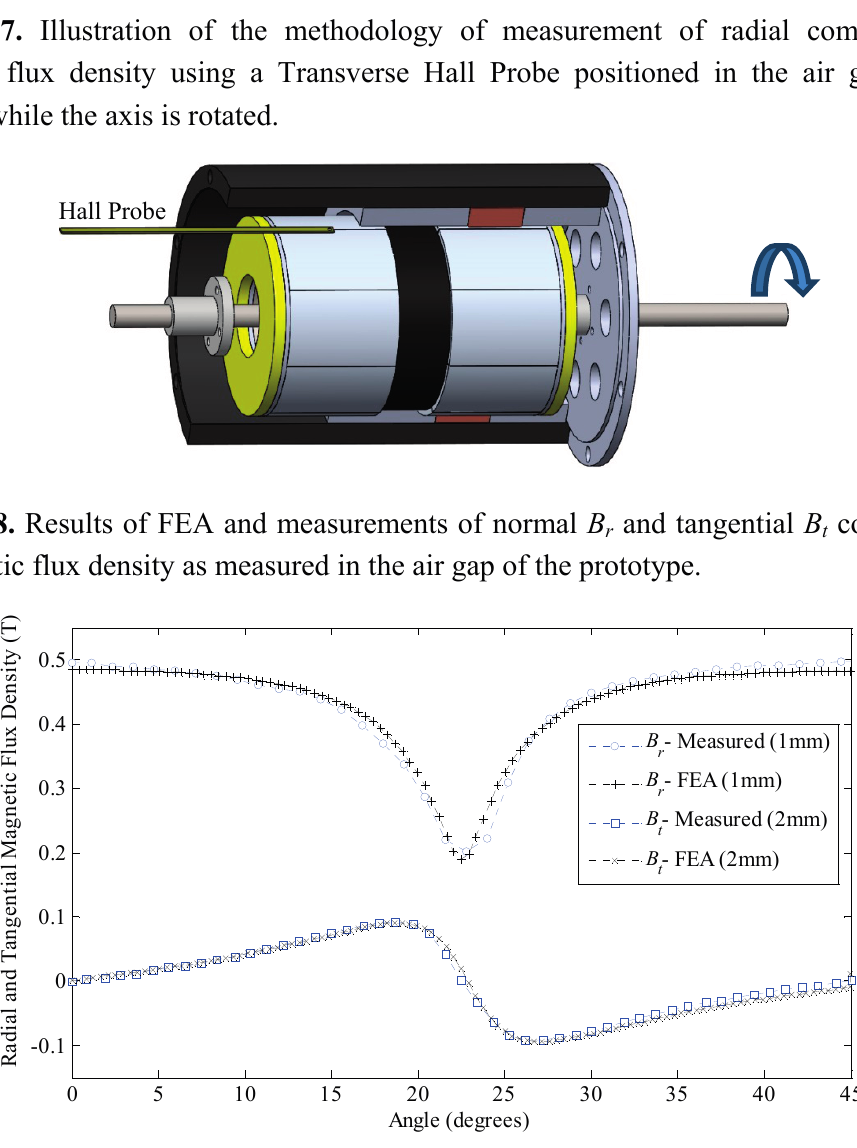
Figure 17. Illustration of the methodology of measurement of radial component of magnetic flux density using a Transverse Hall Probe positioned in the air gap of the actuator while the axis is rotated.